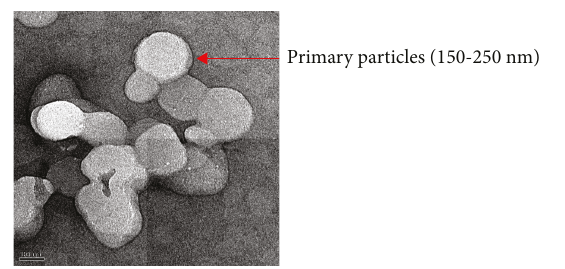
Figure 1: TEM image of SiO